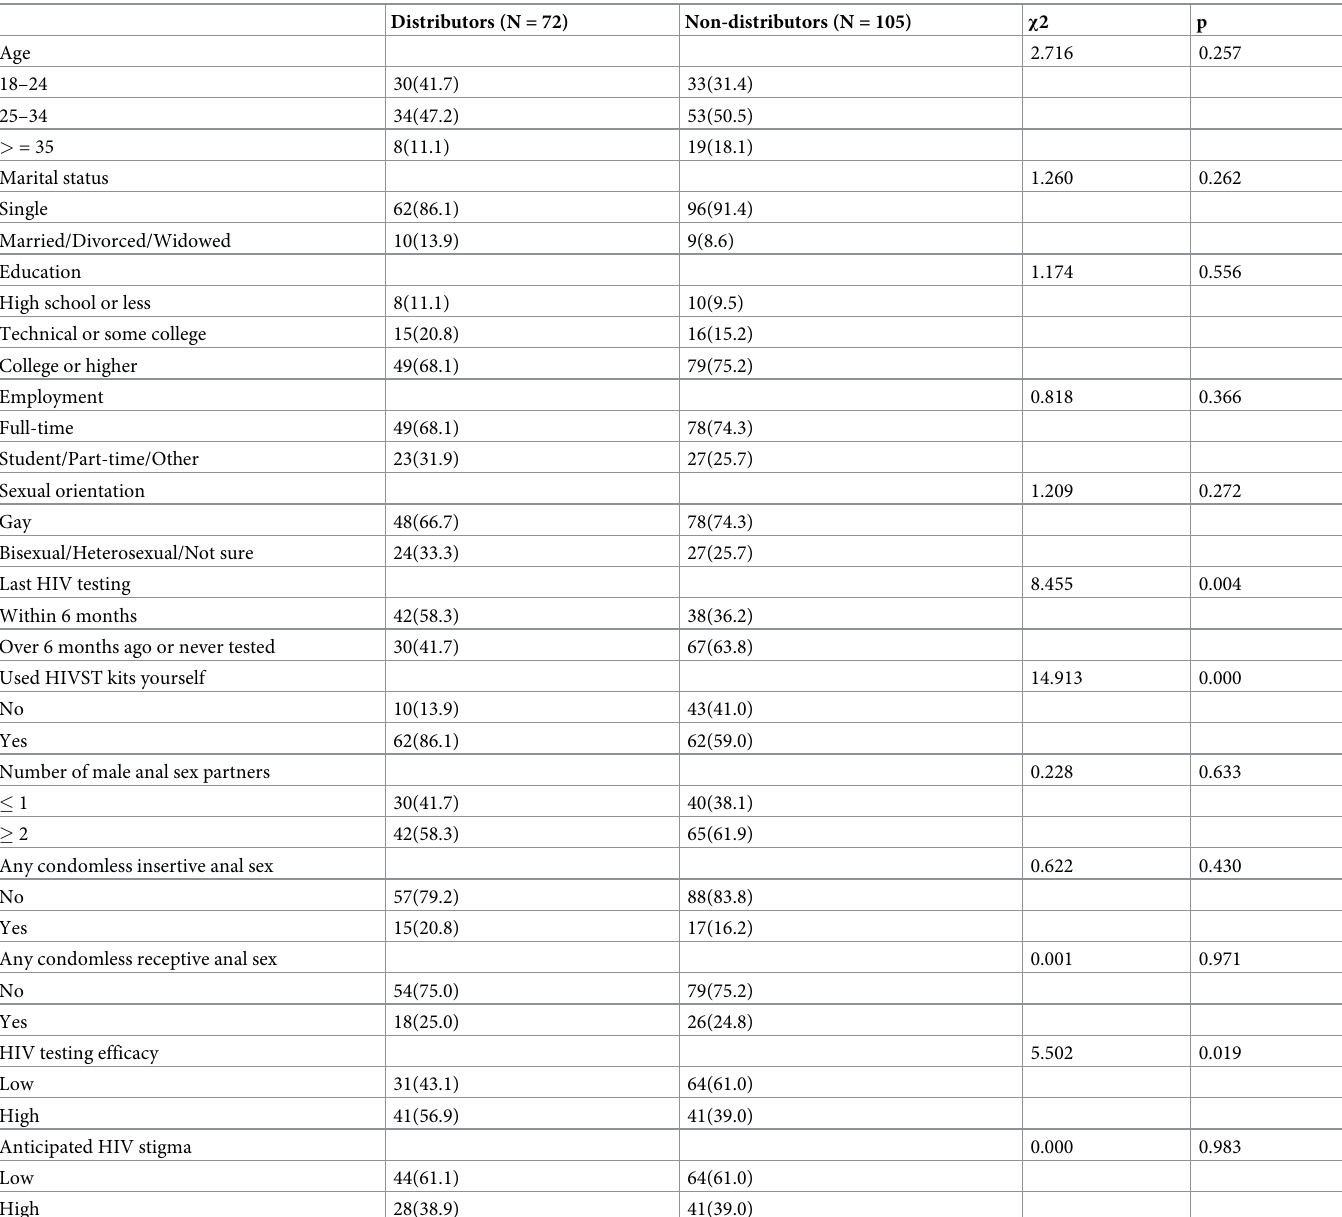
Table 2. Bivariate correlates of distributing HIV self-testing (HIVST) kits to sexual partners among men who have sex with men in Nanjing, China 2017 (N =